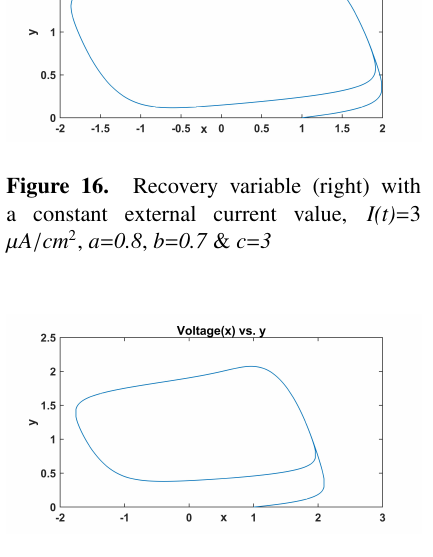
Figure 17. Responses of membrane potential with a constant external current value, I(t) = 4 µ A / cm 2 , a = 0.8 , b = 0.7 & c = 3